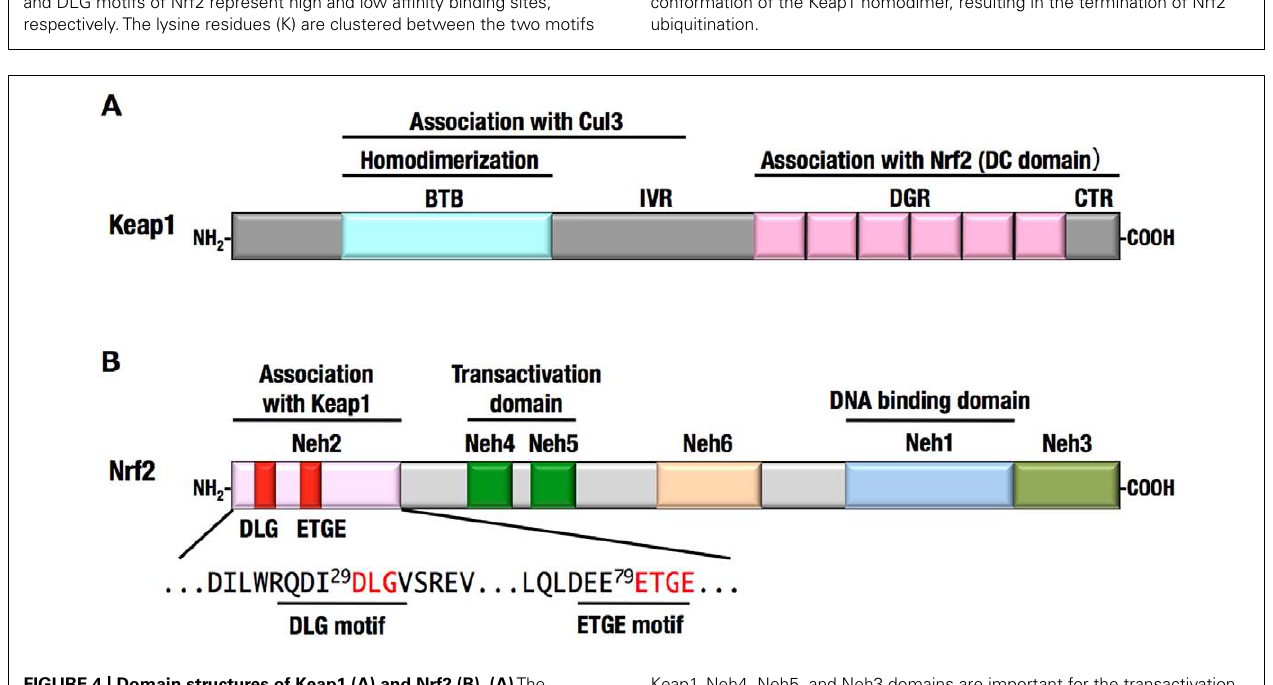
FIGURE 4 | Domain structures of Keap1 (A) and Nrf2 (B). (A) The N-terminal region of Keap1 mediates homodimerization and association with Cul3, and the C-terminal region of Keap1 mediates binding with Nrf2. (B) The N-terminal region of Nrf2 is designated Neh2 domain, which contains two motifs, DLG and ETGE, responsible for the interaction with